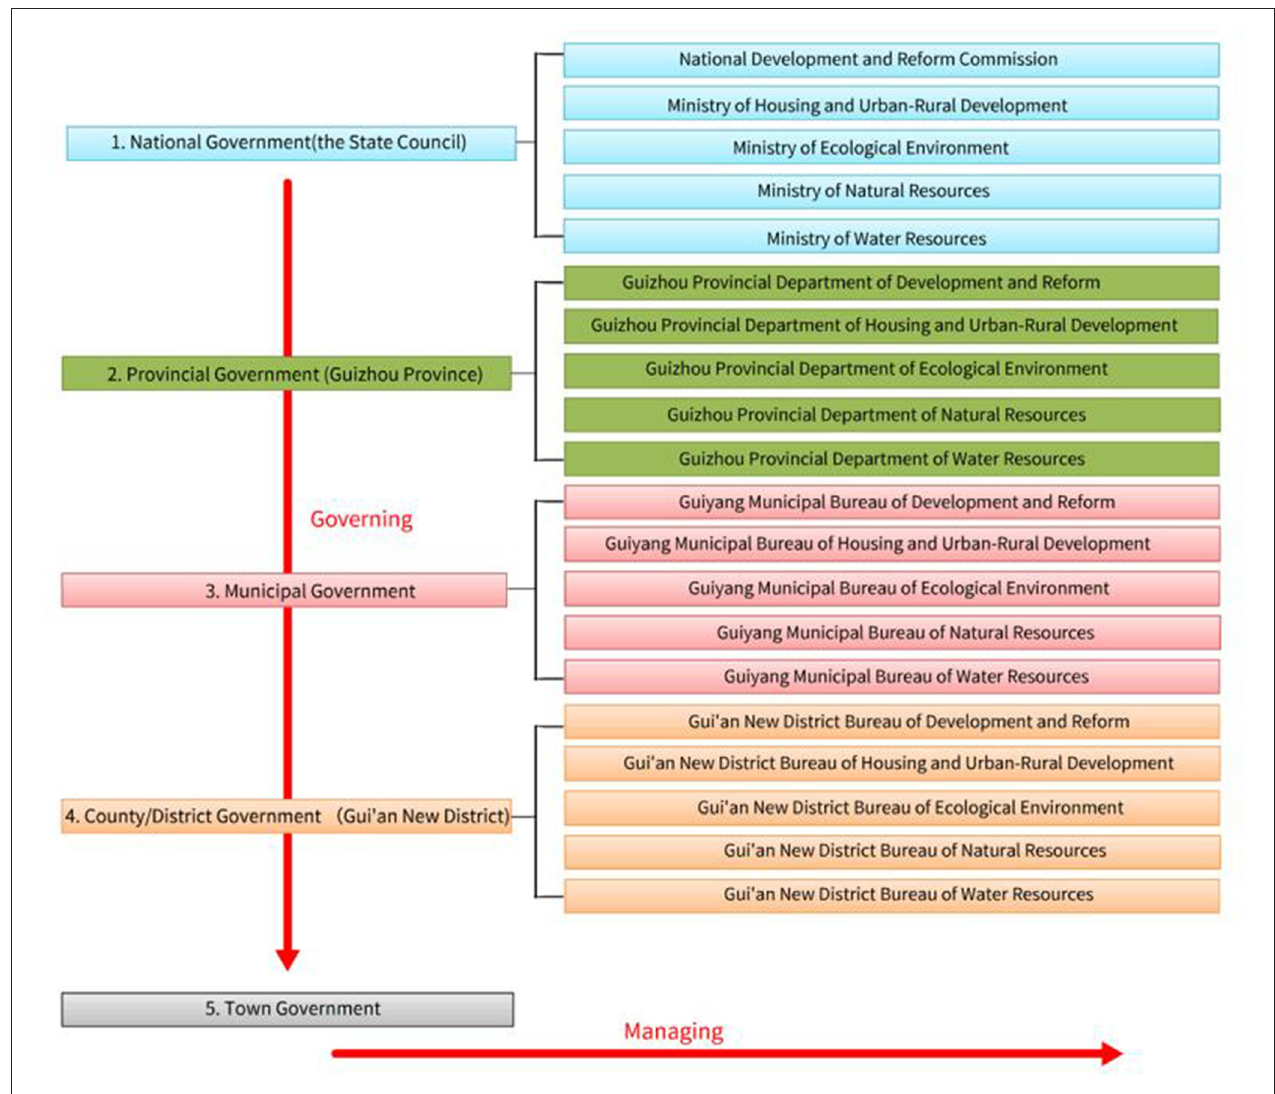
FIGURE 5 | The SCP governing